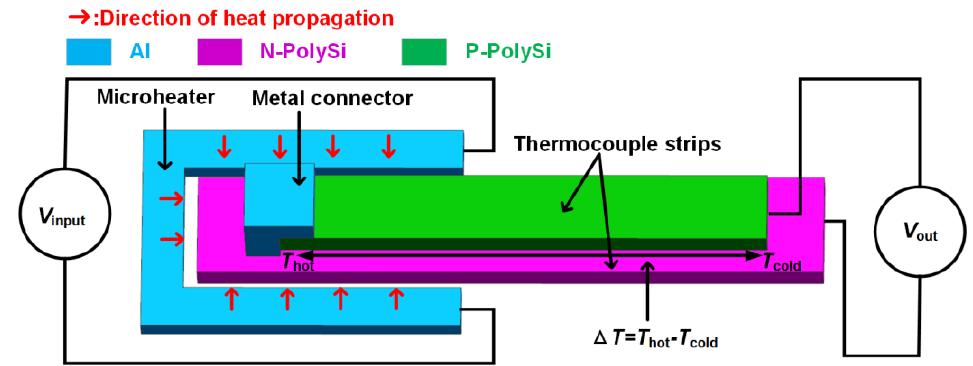
Figure 1. Working principle diagram of a microheater embedded around the hot end of a thermocouple.